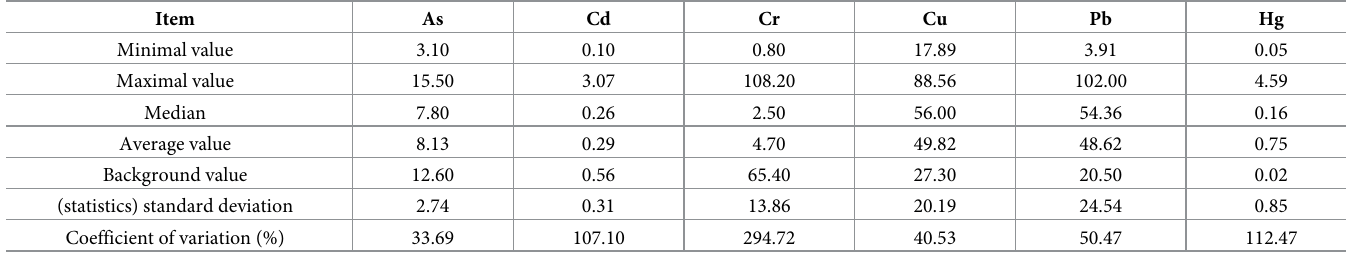
Table 4. Descriptive statistics of heavy metal content in soil of the study area